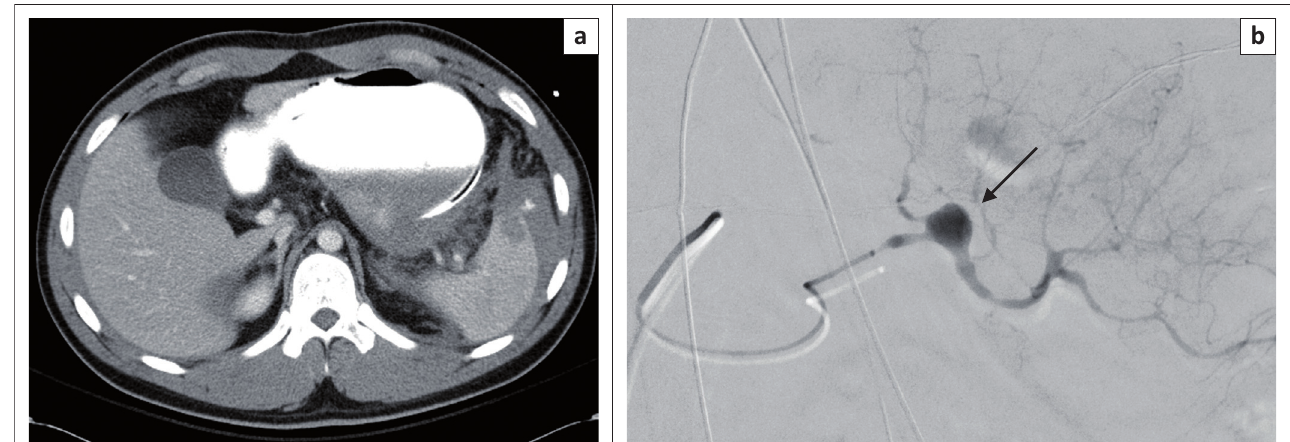
FIGURE 4: Vascular injuries in two patients who failed NOM management with splenic artery embolisation: (a) Patient 1: contrast-enhanced axial CT shows active extravasation of IV contrast (white arrow) beyond the splenic margin and (b) Patient 2: fluoroscopic image from selective splenic artery angiogram shows splenic artery pseudoaneurysm (black arrow).